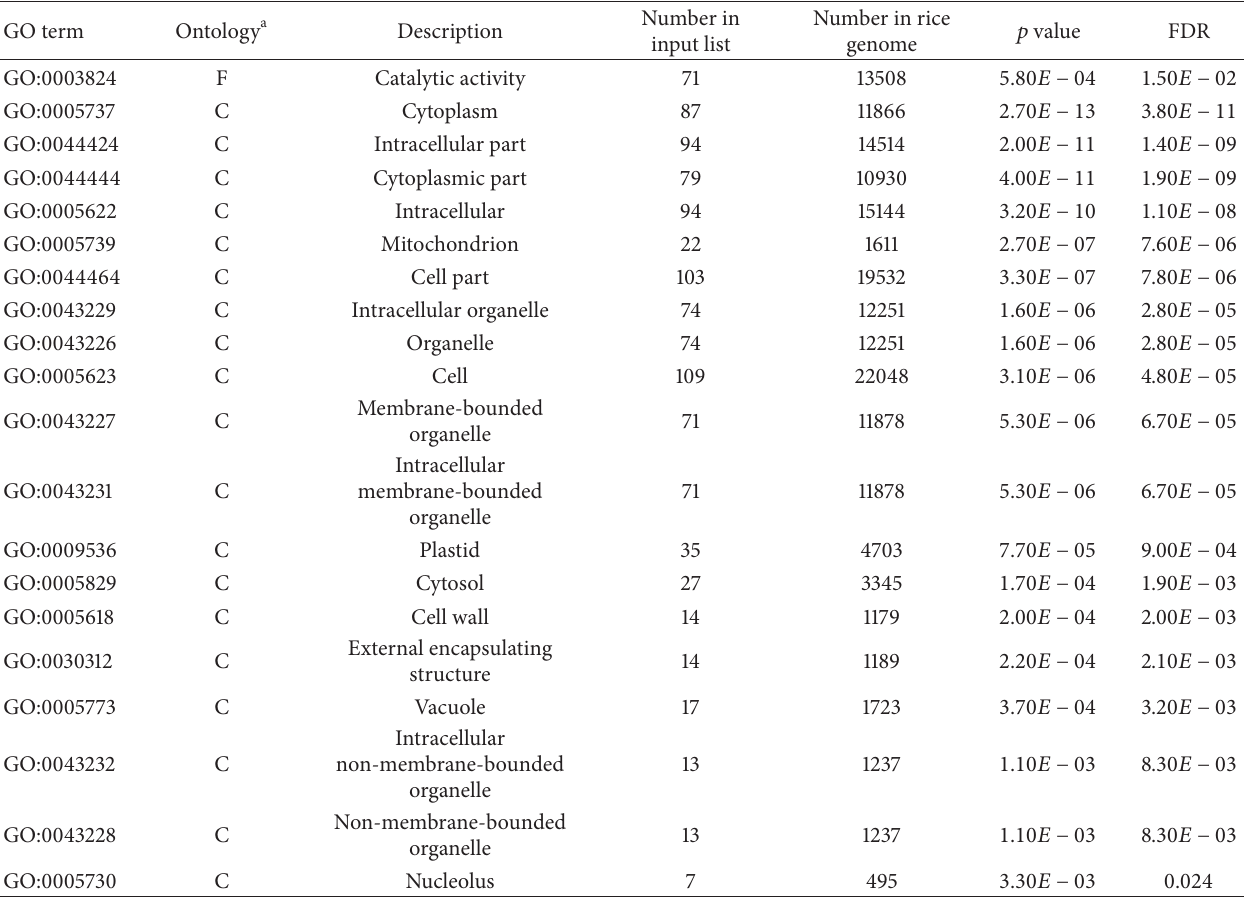
Table 1: Enriched GO terms of the differentially expressed proteins in Dianxi4 anther at high